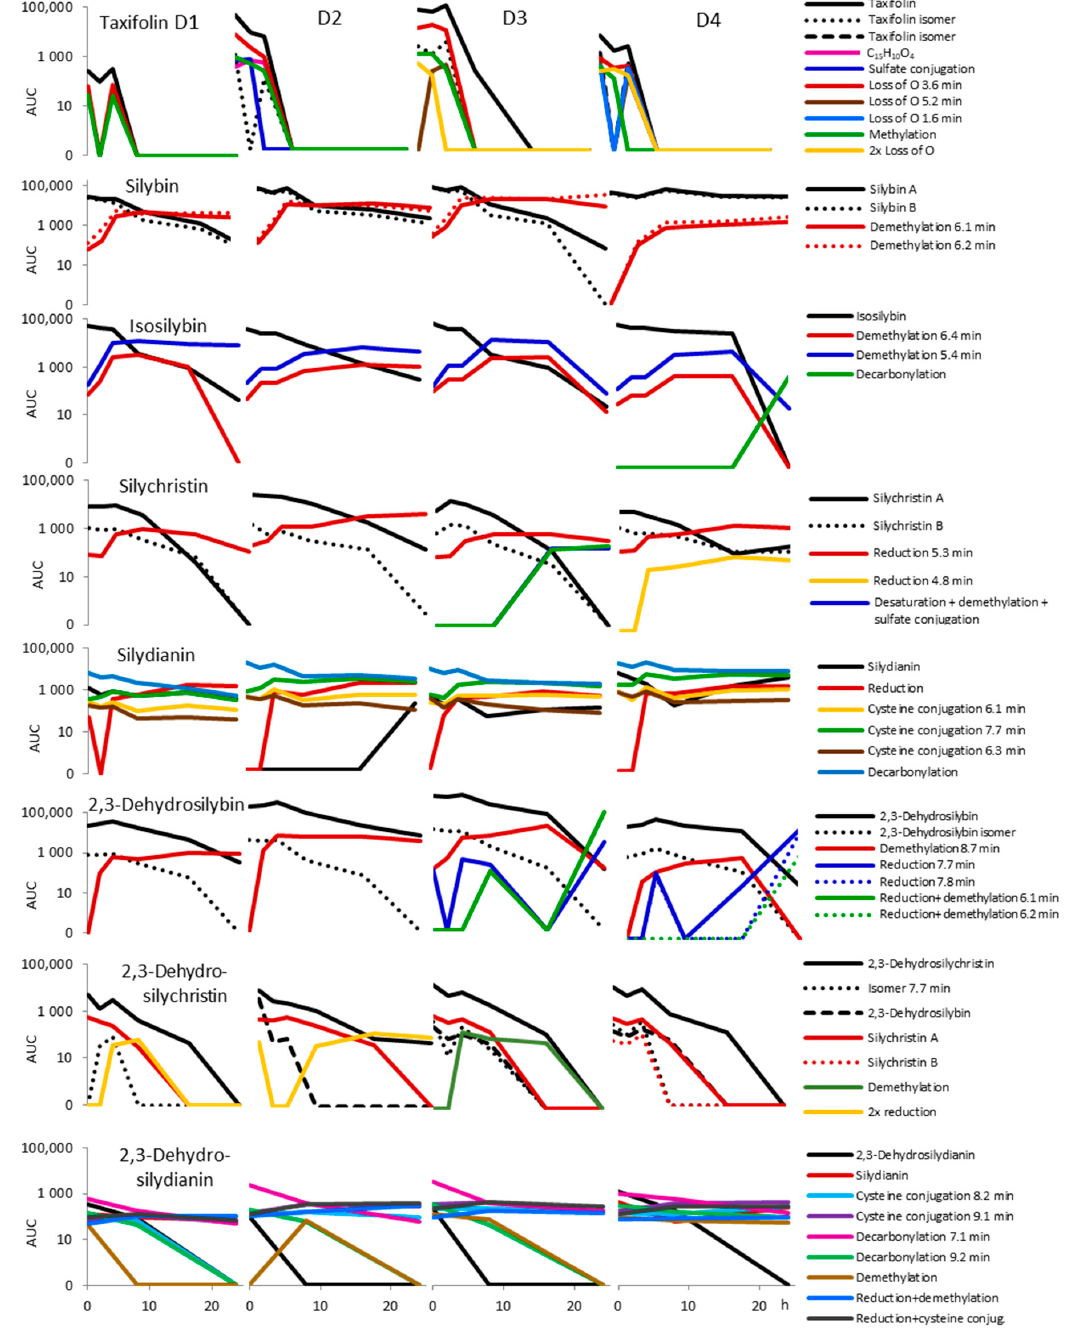
Figure A2. Biotransformation of silymarin components by human fecal microbiota of individual donors D1, D2, D3, and D4 ( cf . Figure 3).